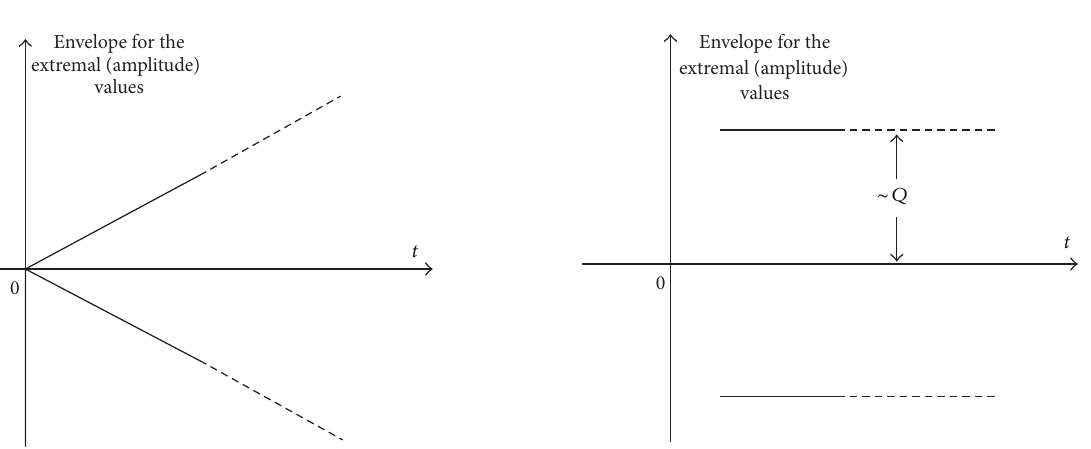
Figure 1: The definition of resonance [1] as linear increase of the amplitude . (The oscillations fill the angle of the envelope.) The infinite process of increase of the amplitude is obtained because of the assumption of losslessness of the system.